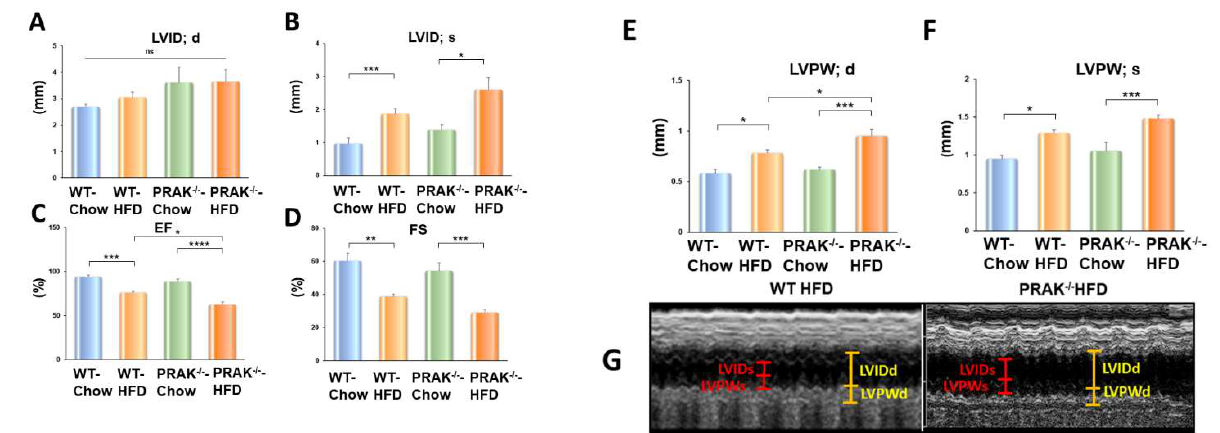
Figure 3. PRAK deletion exacerbates impairment in left ventricular function in HFD-fed mice. Echocardiographic measurements of ventricular functional parameters include ( A , B ) Left Ventricular Internal Dimension in Diastole (LVID;d); Left Ventricular Internal Dimension in Systole (LVID;s); Data are shown as means ± SEM ( n = 5/each group). * p < 0.05, *** p < 0.001; ( C , D ): Ejection Fraction (EF), Fractional Shortening (FS); Data are shown as means ± SEM ( n = 5/each group). * p < 0.05, ** p < 0.01, *** p < 0.001, **** p < 0.0001. ( E , F ): Left ventricular posterior wall (LVPW;d and LVPW;s; Data are shown as means ± SEM ( n = 5/each group). * p < 0.05, *** p < 0.001. ( G ): M-Mode showing the promotion of ventricular enlargement in PRAK − / − mice exposed to HFD as compared to wild type receiving HFD group.